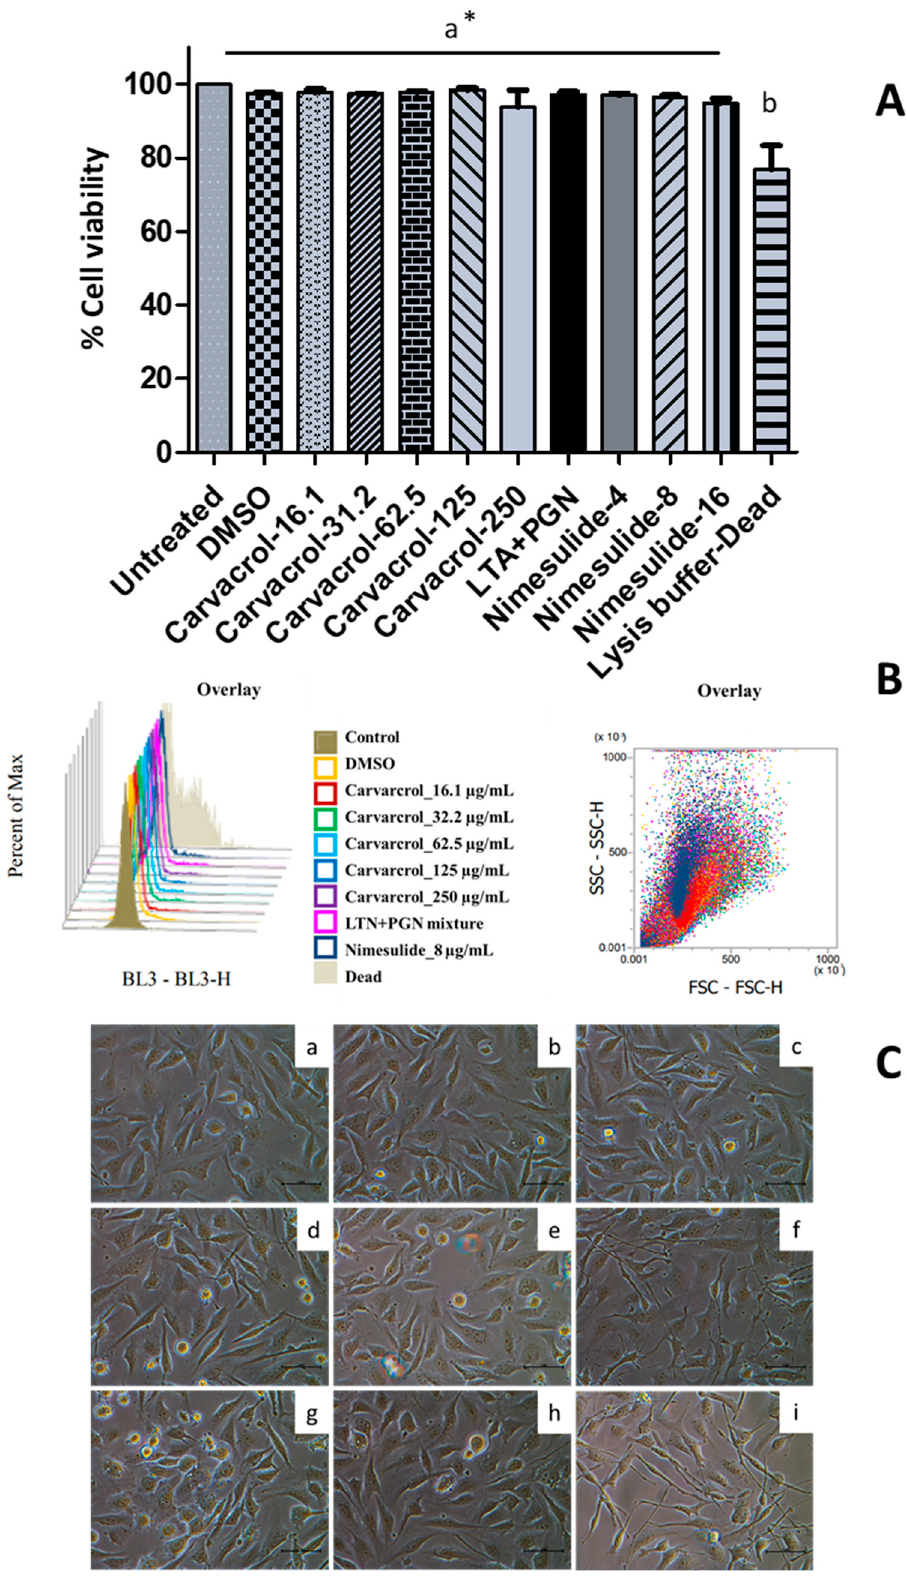
Figure 3. The effect of carvacrol on the viability of human tonsil epithelium cells; ( A ) Cell viability changes with 16.1, 31.5, 62.5, 125, and 250 μ g/mL of carvacrol in DMSO, 4, 8, and 16.1 μ g/mL of nimesulide, lipoteichoic acid (LTA) + peptidoglycan (PGN) (10 μ g/mL each), and 0.05% dimethyl sulfoxide (DMSO) for 24 h were determined using 7-AAD staining followed by flow cytometry